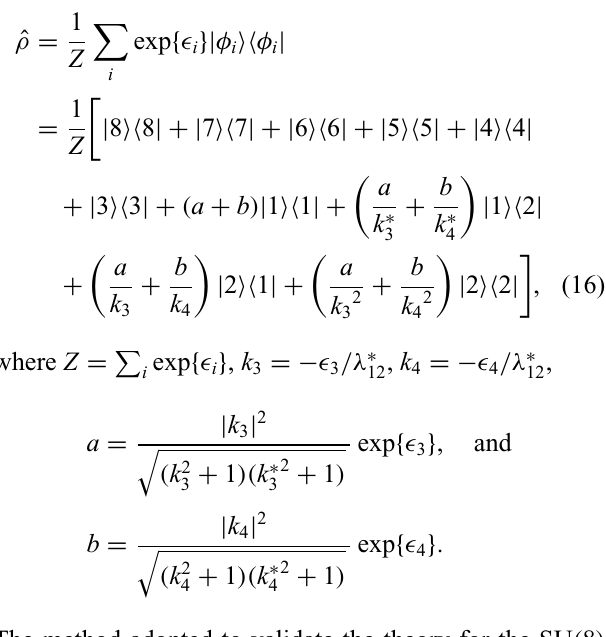
FIG. 6. A sample circuit diagram with variable θ in R y gates for the 3-qubit SU ( 8 ) case and the corre- sponding plots of the true ( x KK ) and predicted ( x A mean values for x KK . The linear plots show that the maximal entropy formalism- based reconstructed